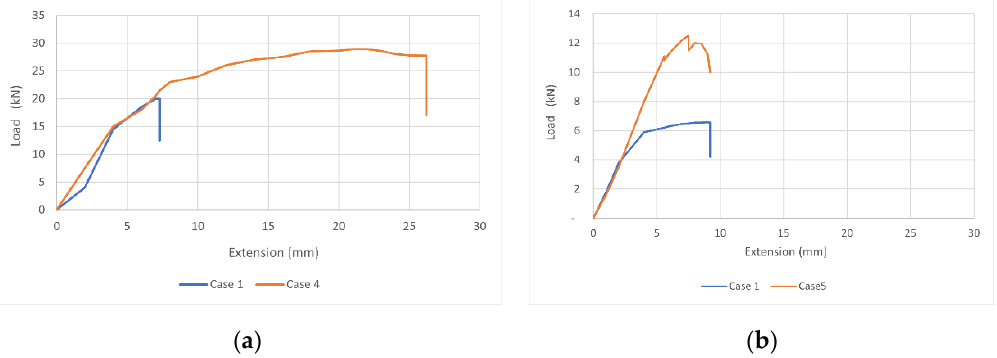
Figure 8. Load vs. extension graph of ( a ) Case 1, 40 × 80 sample pieces, vs. Case 4, 40 × 80 sample pieces; and ( b ) Case 1, 40 × 40 sample pieces, vs. Case 5, 40 × 40 sample pieces.